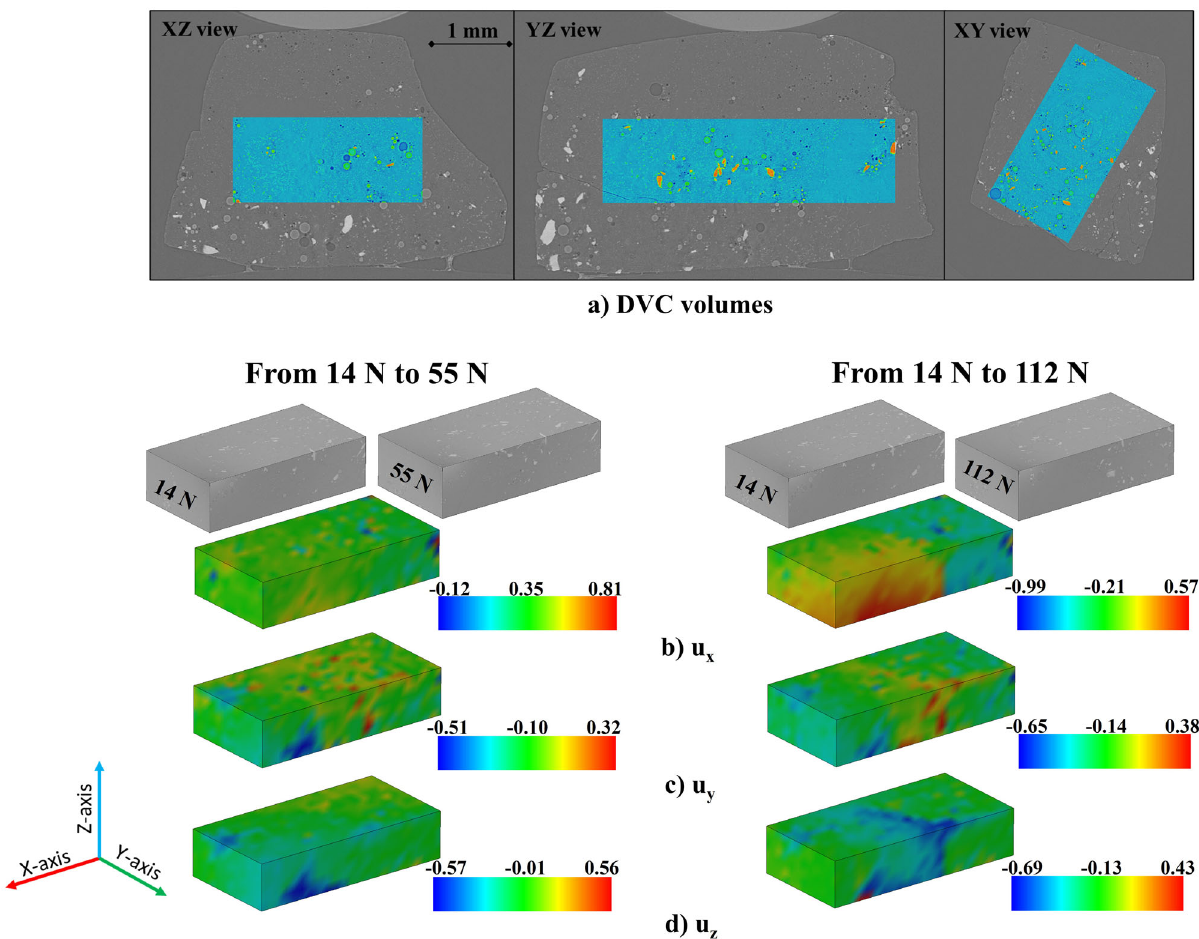
Fig. 7 Orthogonal views and images. a The embedded DVC volumes, corresponding DVC-measured axial displacements b u x , c u y and d u z , developed within the MCCI-simulant volume as external loading progressively increased. Displacements are given in μ